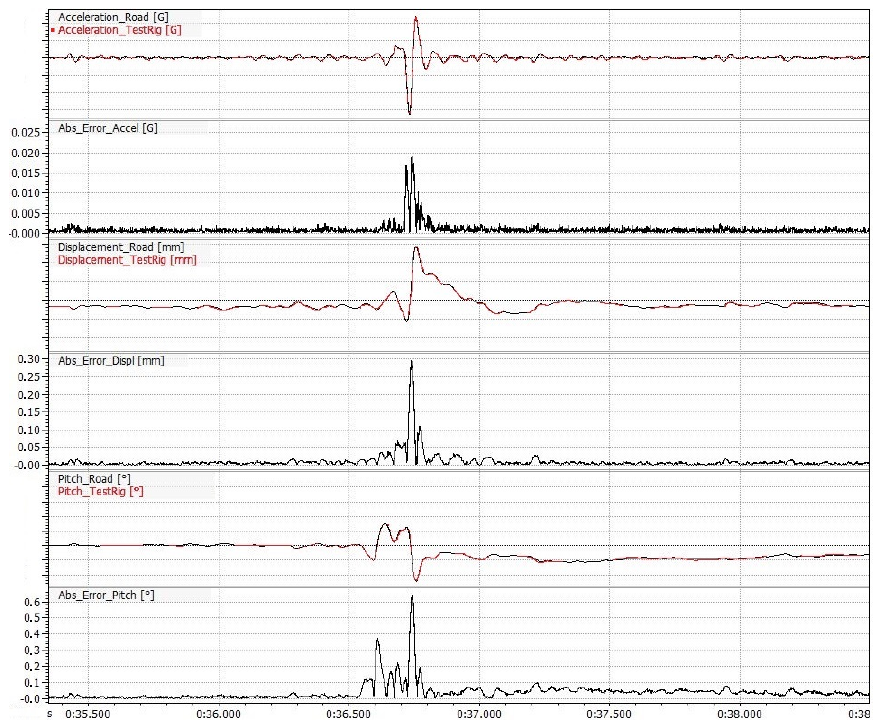
Figure 16. Test performed on a speed hump at 30 km/h.